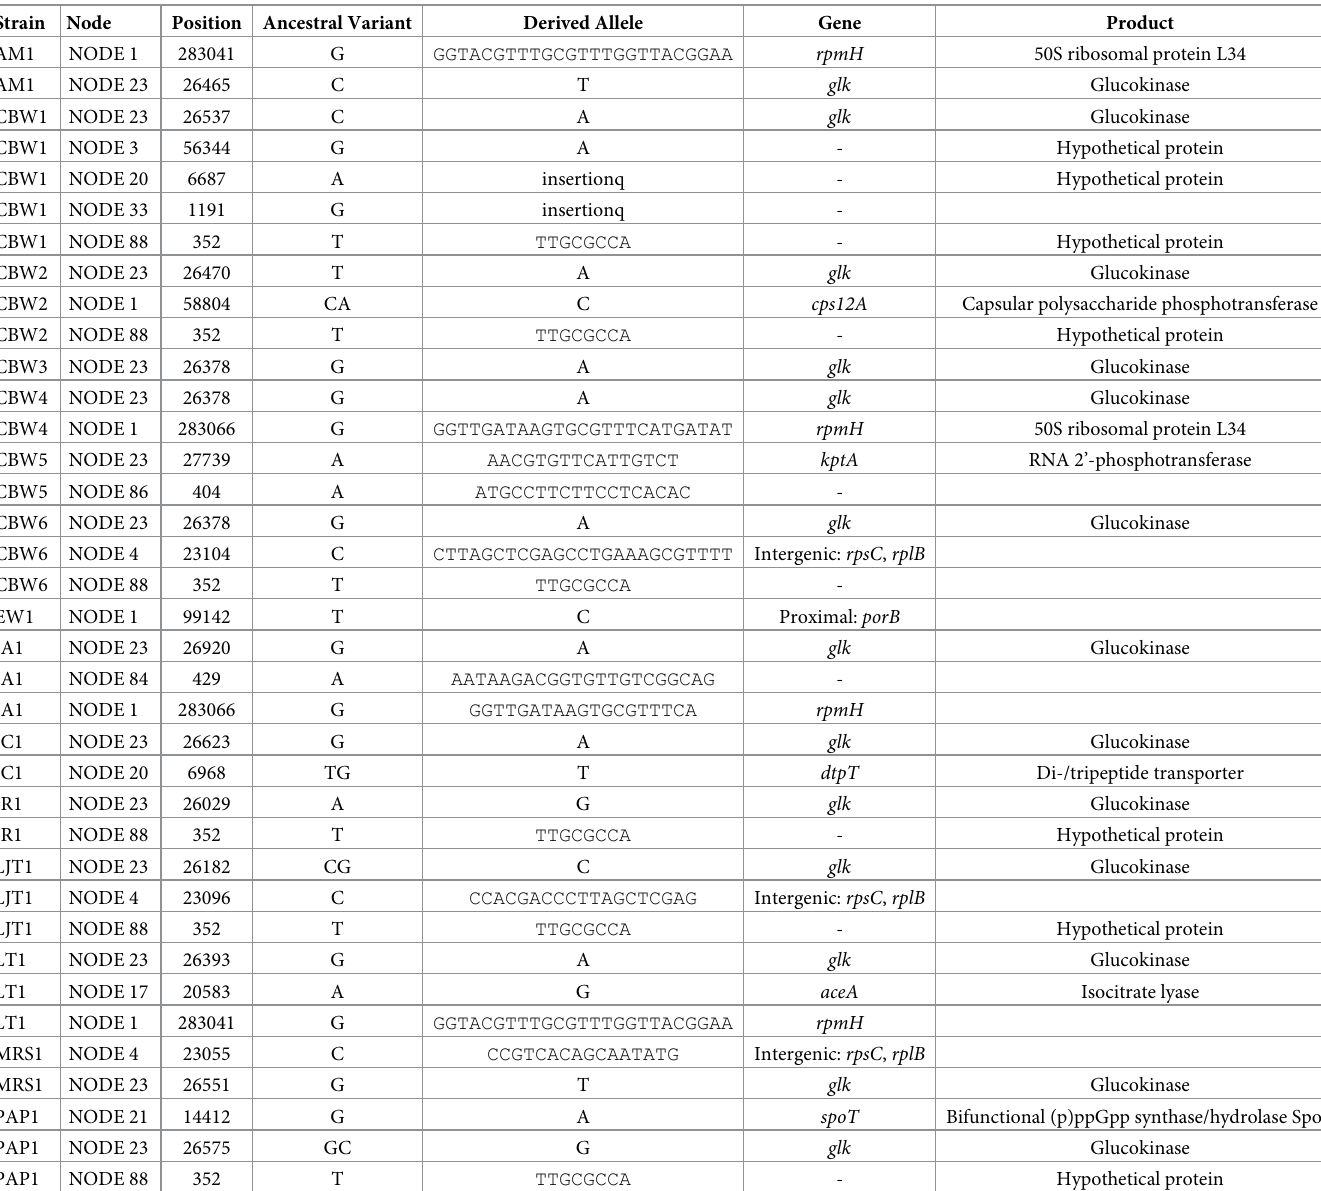
Table 2. Derived SNPs in evolved lineages annotated in reference to the draft AR-0945 assembly (JAFEUH000000000). Strain